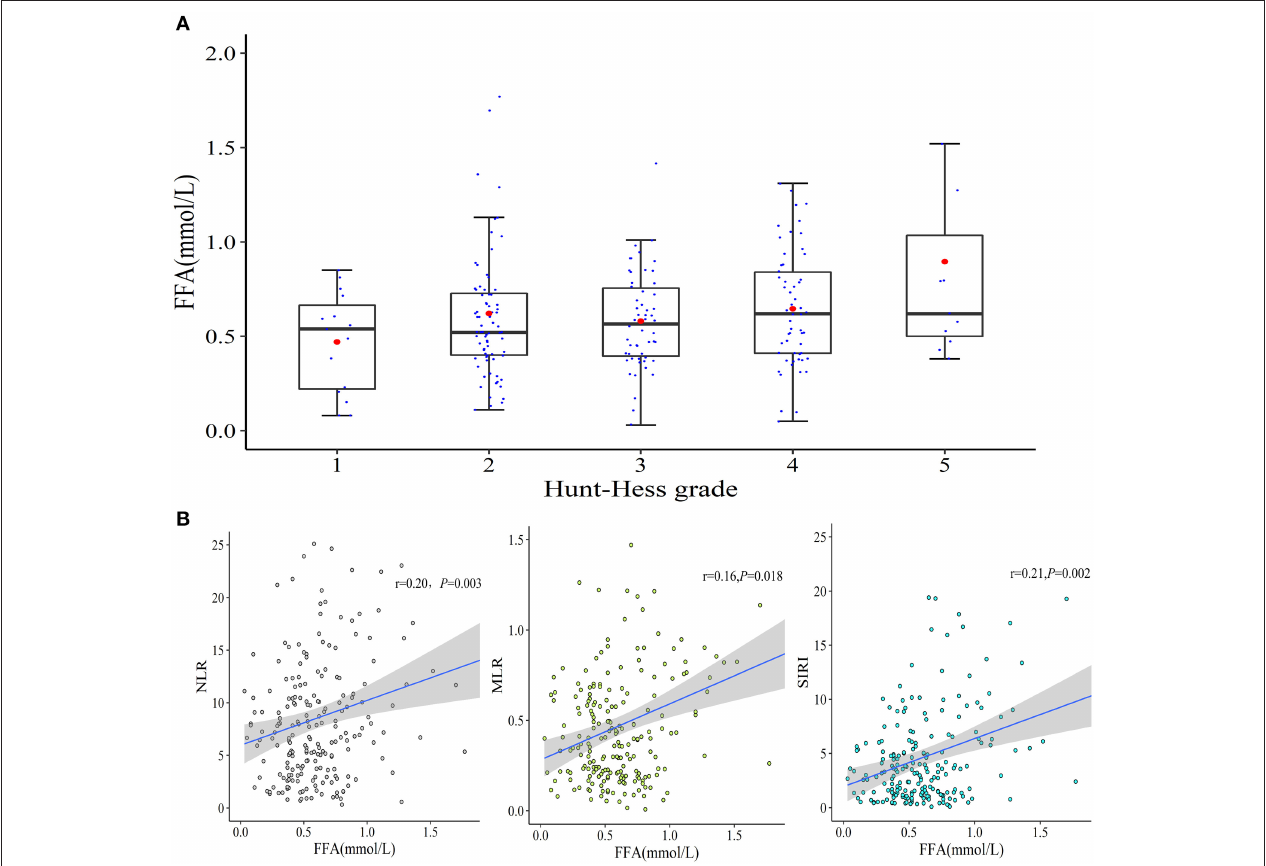
FIGURE 2 | The correlations between admission FFA levels and aSAH characteristics. (A) A weak correlation between admission FFA levels and initial HH grade was observed ( r = 0.141 and P = 0.04). (B) Correlations between serum FFA levels and NLR, MLR, and SIRI. TABLE 2 | Univariate and multivariate logistic regression analyses of risk factors associated with 3 months poor outcome. Parameter Univariate analysis Multivariate analysis OR 95% CI P Adjusted OR 95%